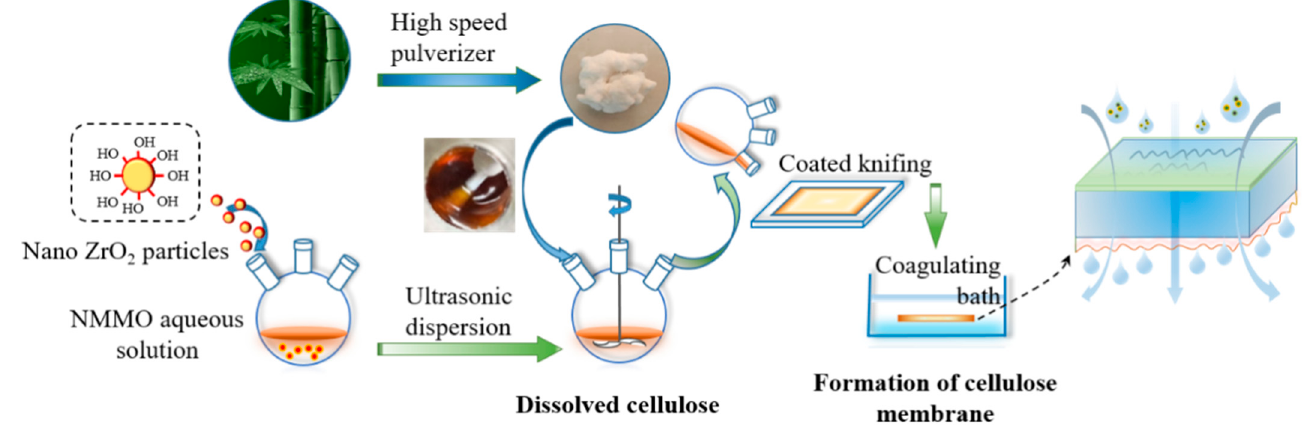
Figure 1. The scheme of the preparation of ZrO 2 /BCM.